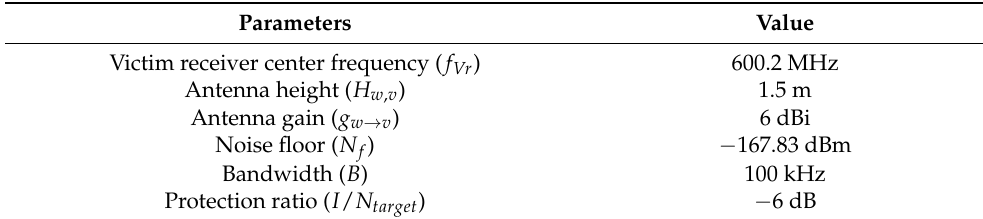
used in the simulation. Table 2. Victim link